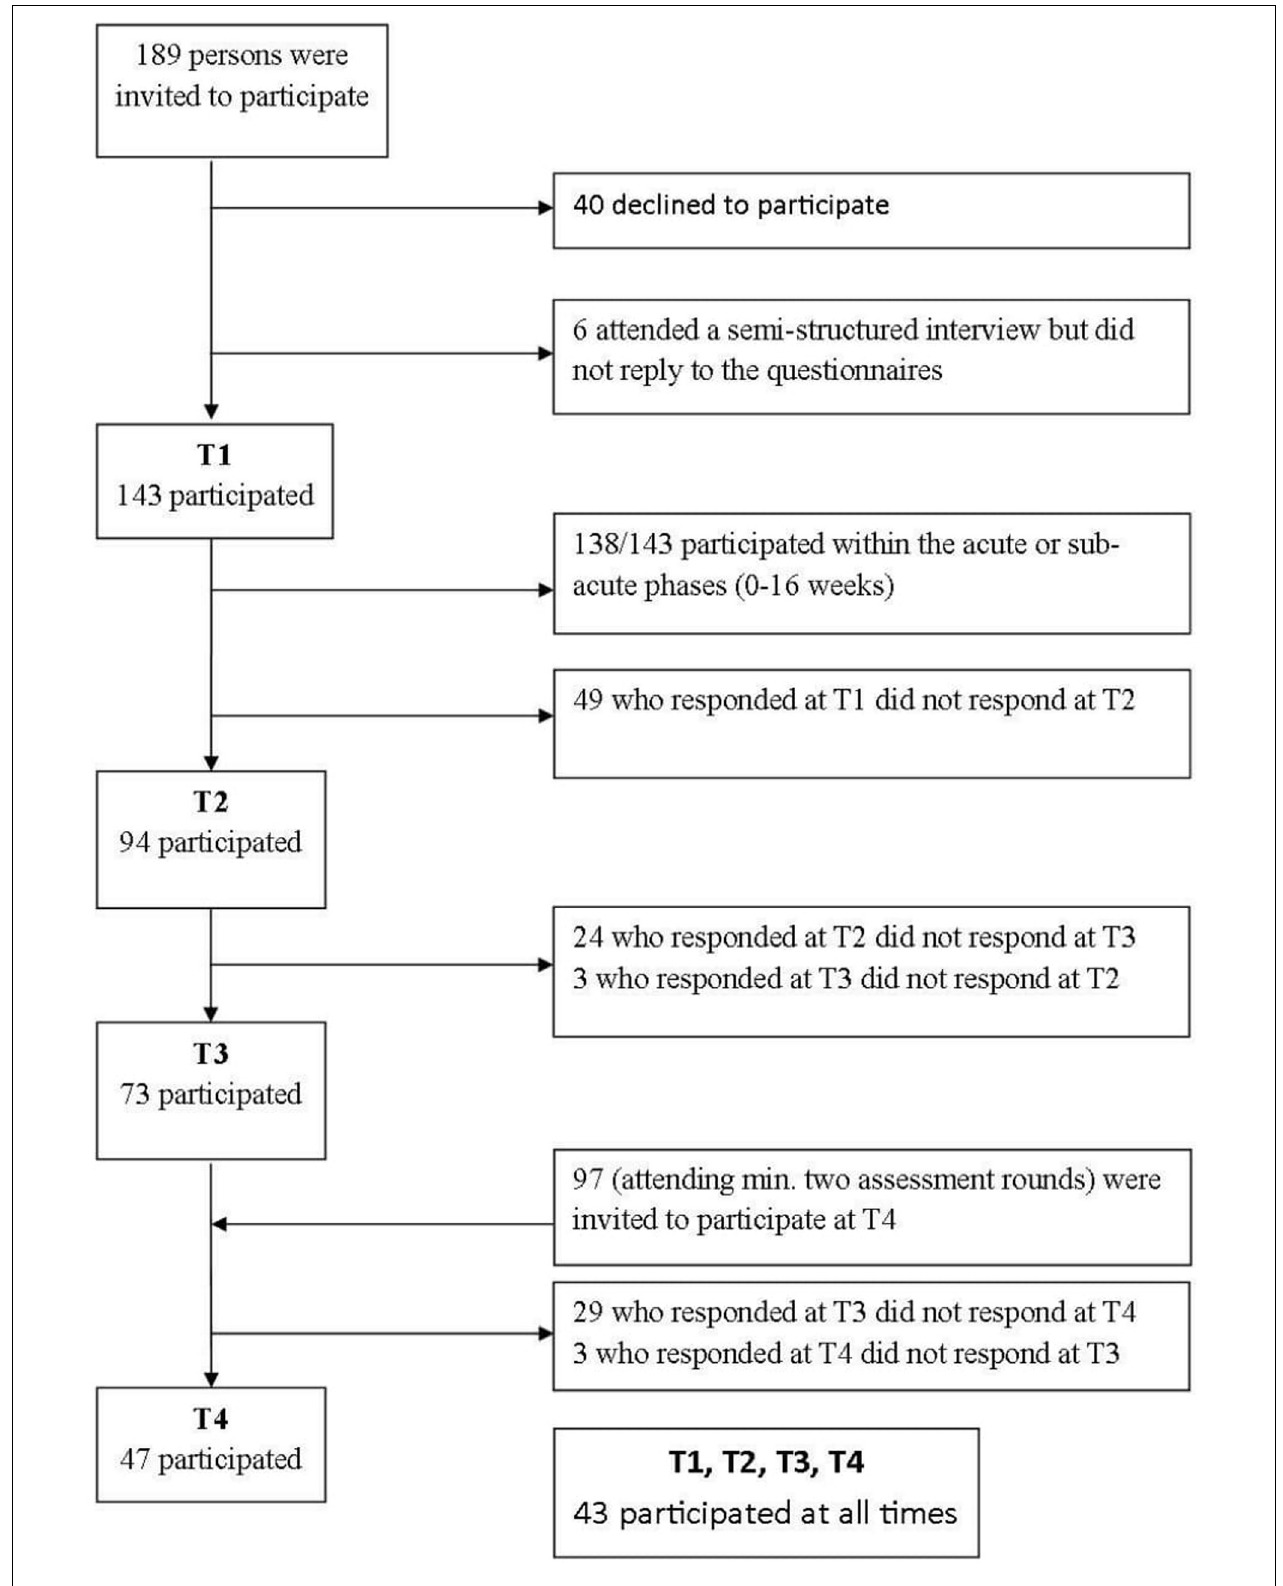
FIGURE 1 | Flowchart for inclusion of